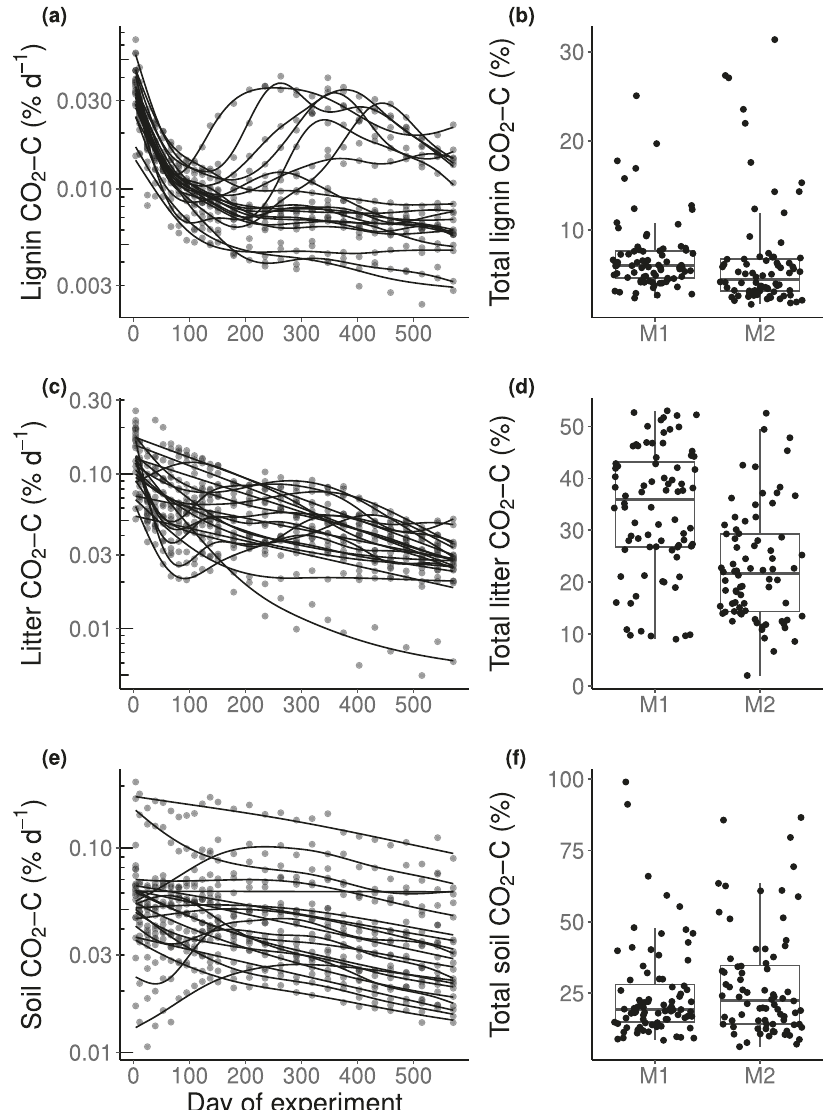
Fig. 2 | Carbon (C) decomposition (CO 2 -C) from lignin, litter, and soil in lab- incubatedsamplesfrom20NEONsites,expressedasapercentageoftheinitial Cmassineachpool. Notethebase-10logarithmic y axisscaleforCdecomposition rate ( a , c , e ). M1 and M2 denote mineral soil samples from 0 – 15 and 15 – 30cm, respectively. Total C decomposition (CO 2 -C) represents cumulative C decomposi- tion over 18 months. Lines are fi t by generalized additive mixed models (GAMMs). Each point in left panels ( a , c , e ) represents mean decomposition rate from four sampling points across two soil depths at each site ( n =8 biologically independent